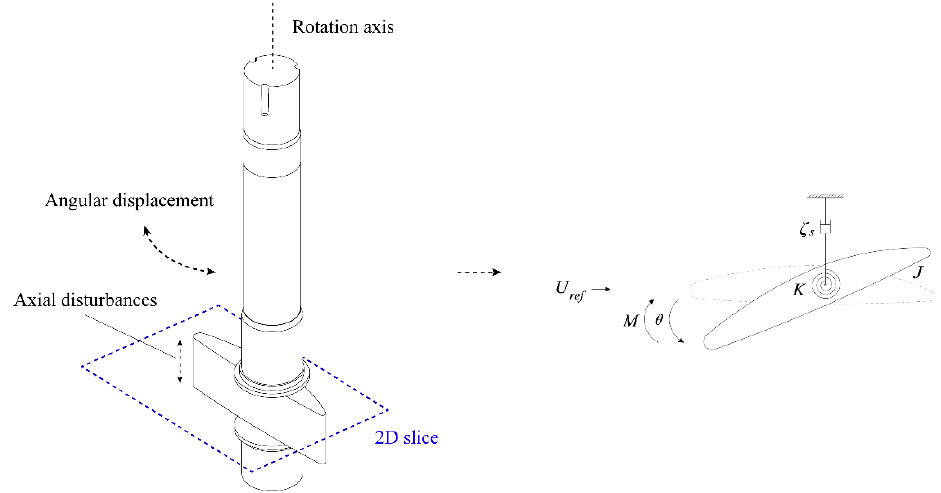
Figure 6. Sketch of flow-induced vibration in the torsional mode of GV.